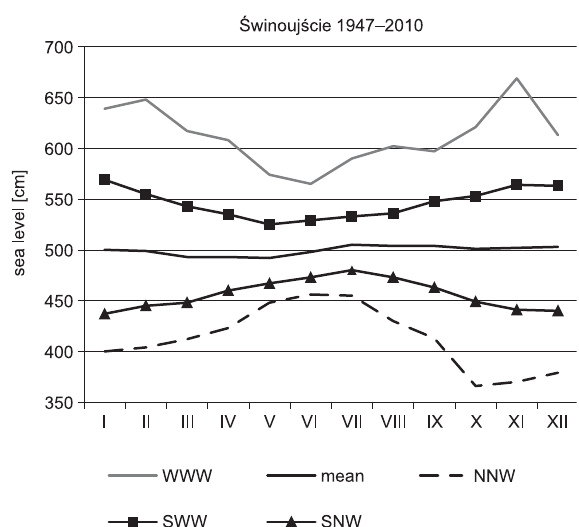
average)Fig. 7. Characteristic, monthly sea levels in